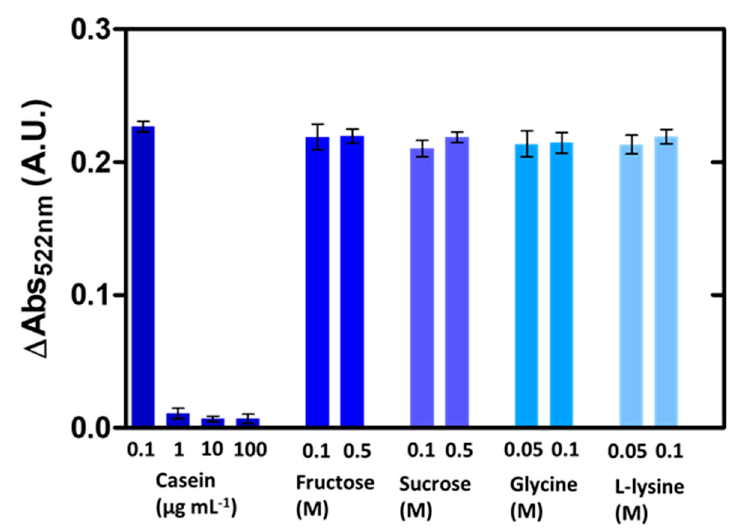
Figure 4. Modulation of the ferricyanide dissociation by small-sized biomolecules. Absorbance variation at 522 nm of AuNPs (with respect to untreated NPs) exposed to casein, fructose, sucrose, glycine and L-lysine after reaction with ferricyanide (error bars represent the standard deviation, n = 3).